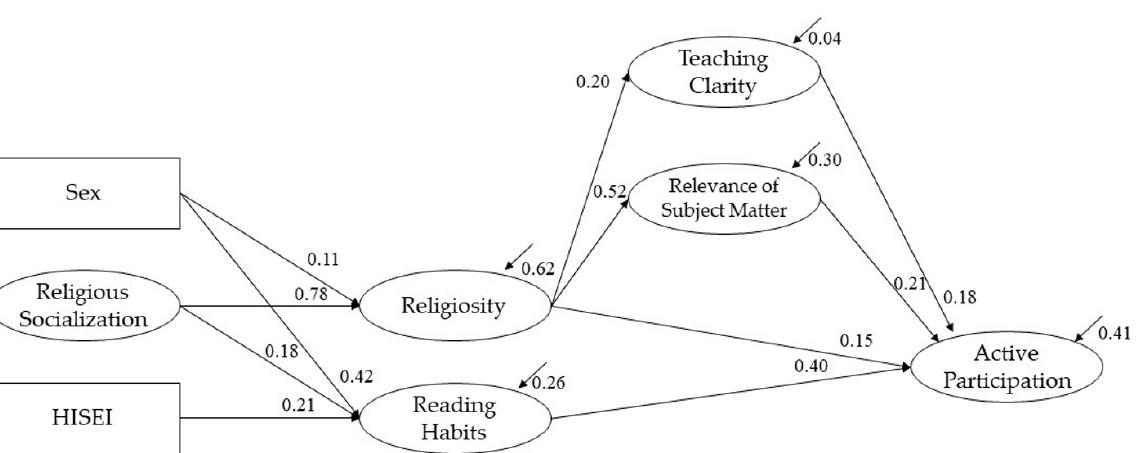
about the model fit: χ 2 (d.f. = 307; N = 751) = 872.728 ( p = 0.000); χ 2 /d.f. = 2.84; RMSEA = 0.052; CFI= 0.916; TLI = 0.924. Only those path coefficients that reach a significance level of p < 0.05 are documented in the figure. Further information on the confirmatory factor analyses of the scales included in the structural equation model can be found in Table A2 in the Appendix A.